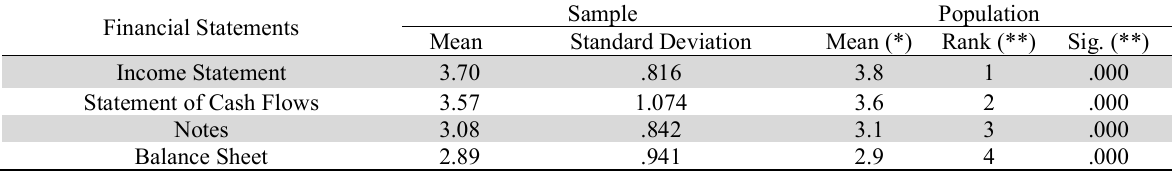
The influencing degree of financial statements on the decision making of individual